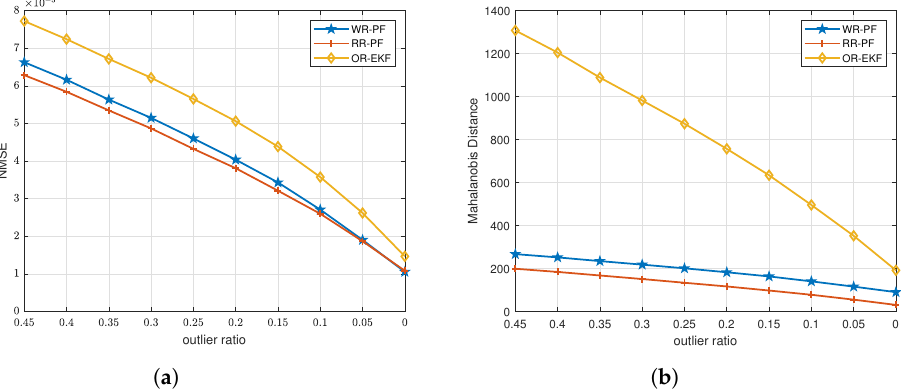
Figure 7. Estimated errors versus only azimuth outliers in multidimensional measurements. ( a ) NMSE comparisons. ( b ) Mahalanobis distance